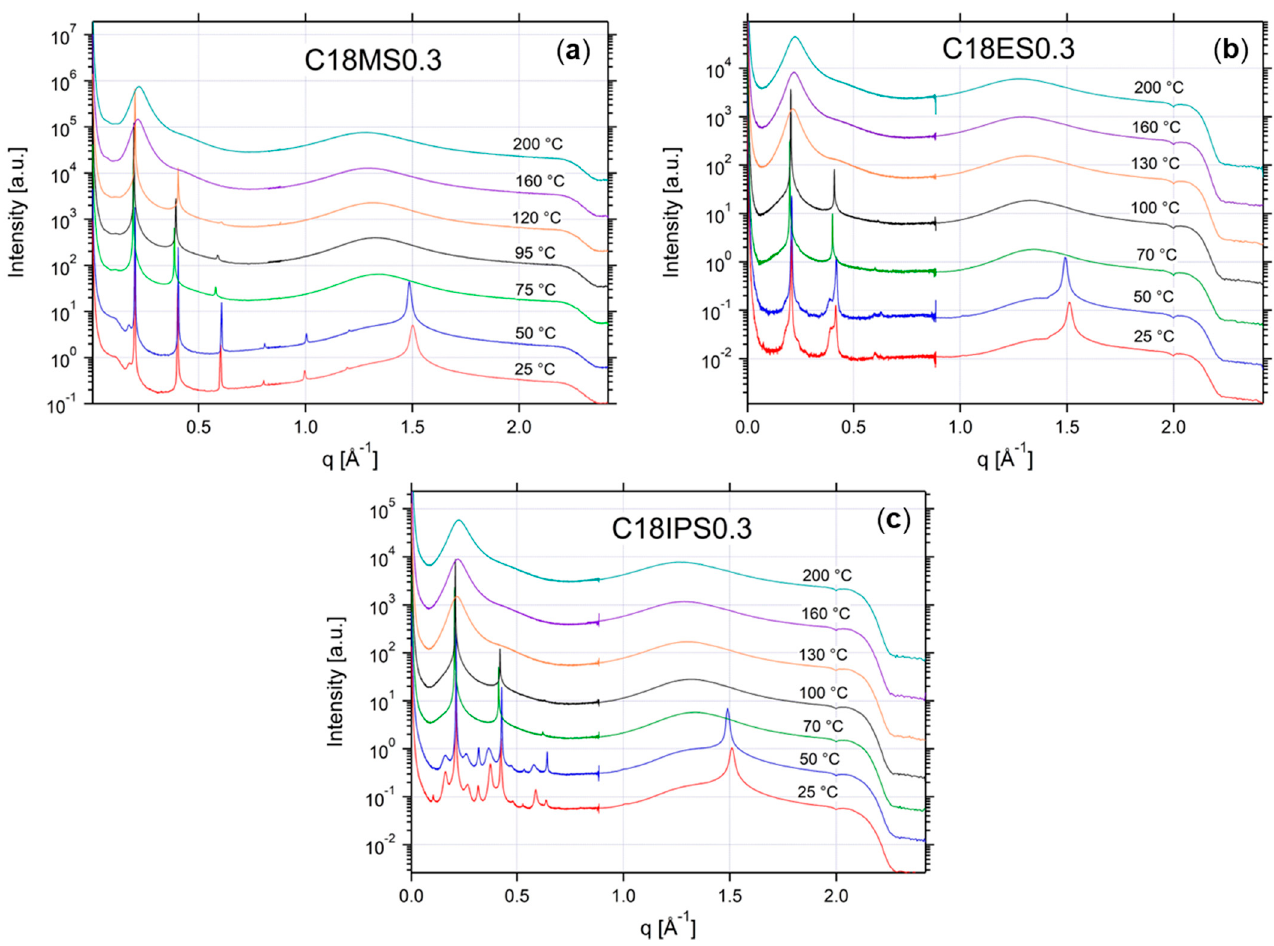
Figure 4. SAXS and WAXS measurements for 0.3:1 ratio blend electrolytes of ( a ) C18MS, ( b ) C18ES, and ( c ) C18IPS with C18LiTFSI on cooling from 200 °C to 25 °C.